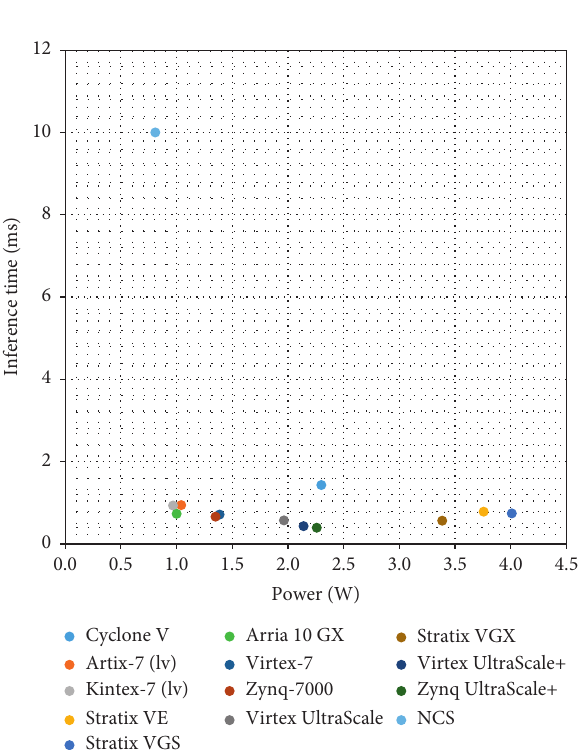
Figure 12: Inference time/power consumption trade-off